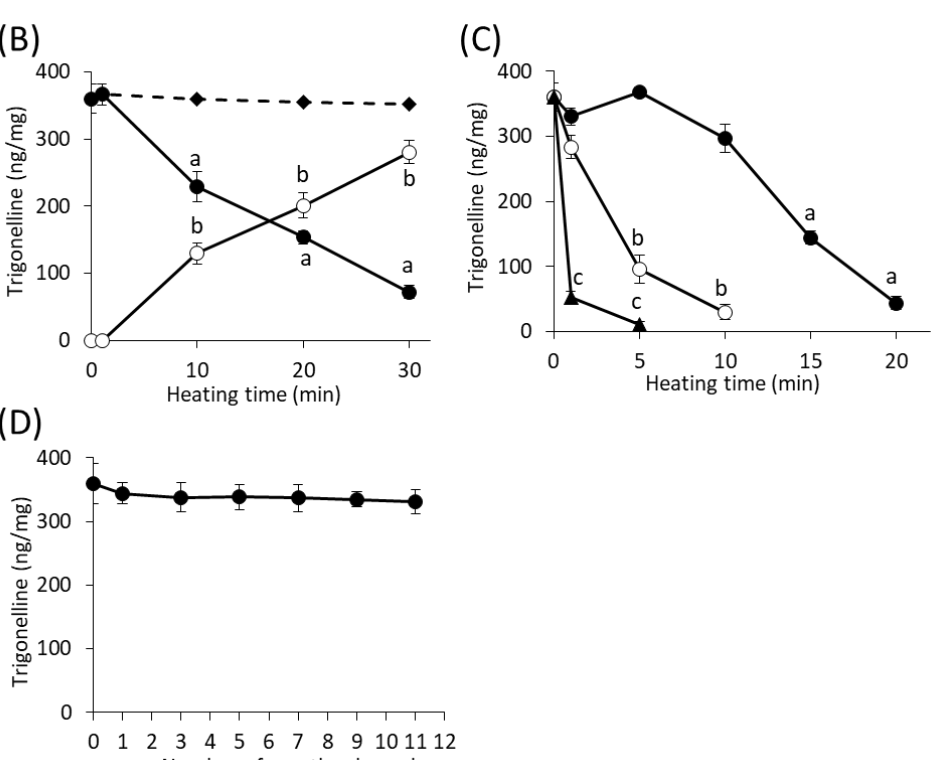
Figure 3. ( A ) Effects of cooking and processing on trigonelline content. ( B ) Time-dependent changes in trigonelline content in radish (black circles), infusion (white circles), and toral (broken line) after heating in hot water at 100 °C. ( C ) Changes in trigonelline contents after heating in an oven at 180 °C (black circles), 185 °C (white circles), or 190 °C (black triangles). ( D ) Time course of changes in trigonelline contents when stored in a freezer at −30 °C. All values are represented as means ± SD. For each time point, means with a different letter are significantly different, p < 0.05.